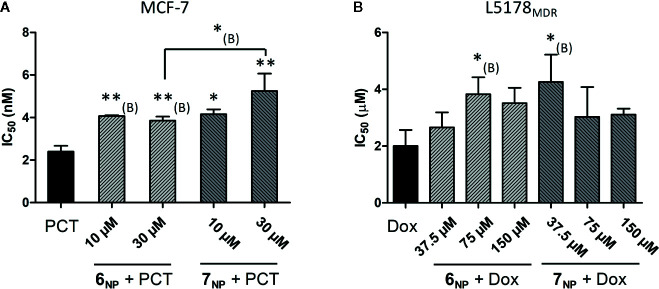
Interaction of 6NP and 7NP with paclitaxel on MCF-7 (A) and with doxorubicin on L5178MDR cells (B). The bars show the IC50 values of the chemotherapeutic agent with or without the presence of a given fix concentration of 6NP or 7NP, error bars show SEM. For the results shown in (B), the nanosuspensions were preincubated with 6x volume of horse serum for 24 h. * and **: p < 0.05, and p < 0.01, respectively, by one-way ANOVA followed by Dunnett’s post-hoc test as compared with the single treatment; *(B) and **(B): p < 0.05, and p < 0.01, respectively, by one-way ANOVA followed by planned comparisons with the single treatment or with the specified other combination by Bonferroni’s post-hoc test.